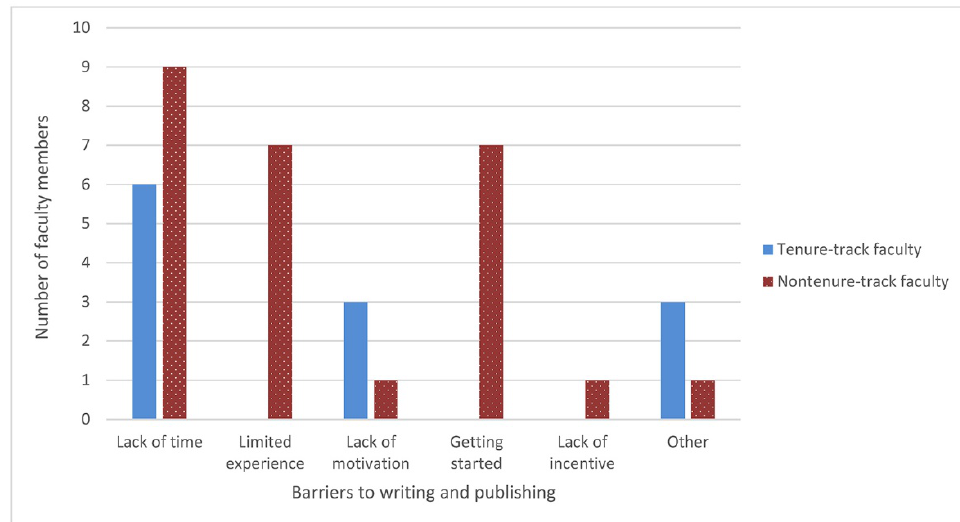
Figure 2 Barriers to writing for publication before participation in the Scholarship Circle by faculty